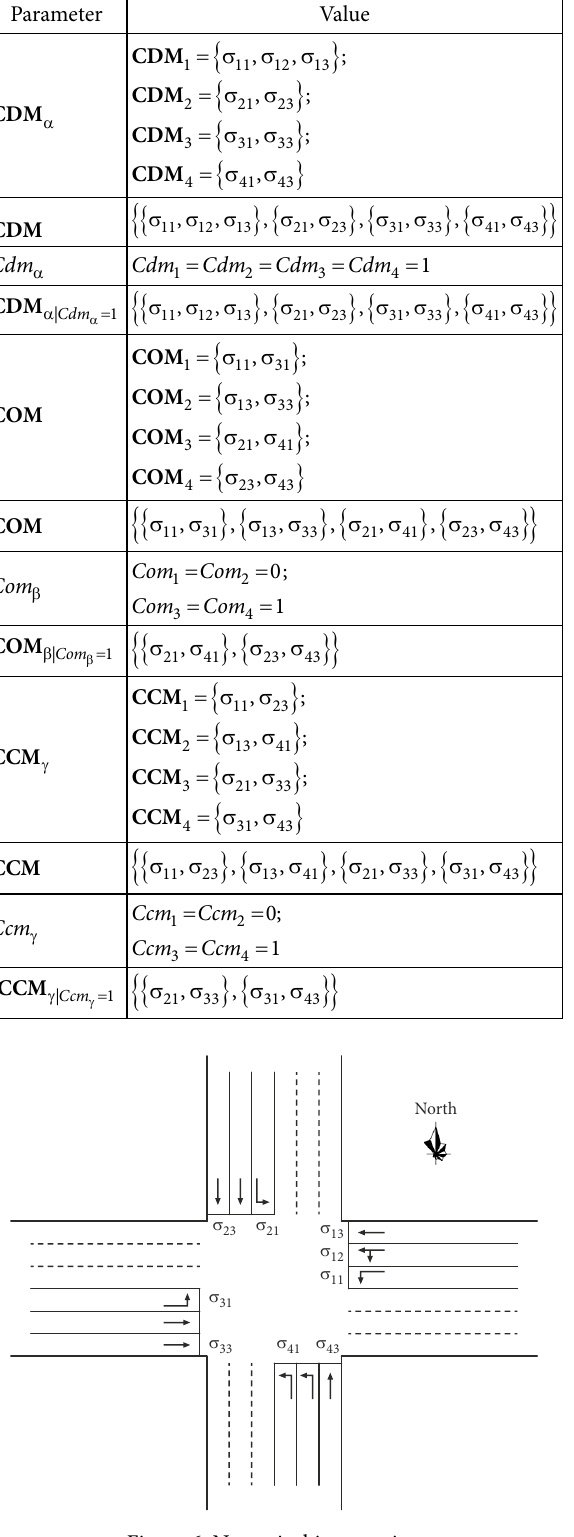
Figure 6. Numerical intersection